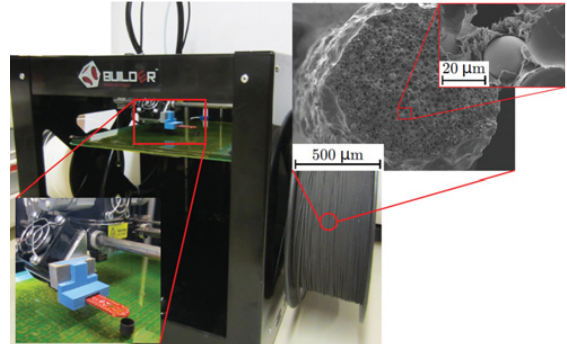
Figure 2. 3D printer used for manufacturing, and scanning electron microscope (SEM) image of the filament material Neofer (cid:1) 25/60p.